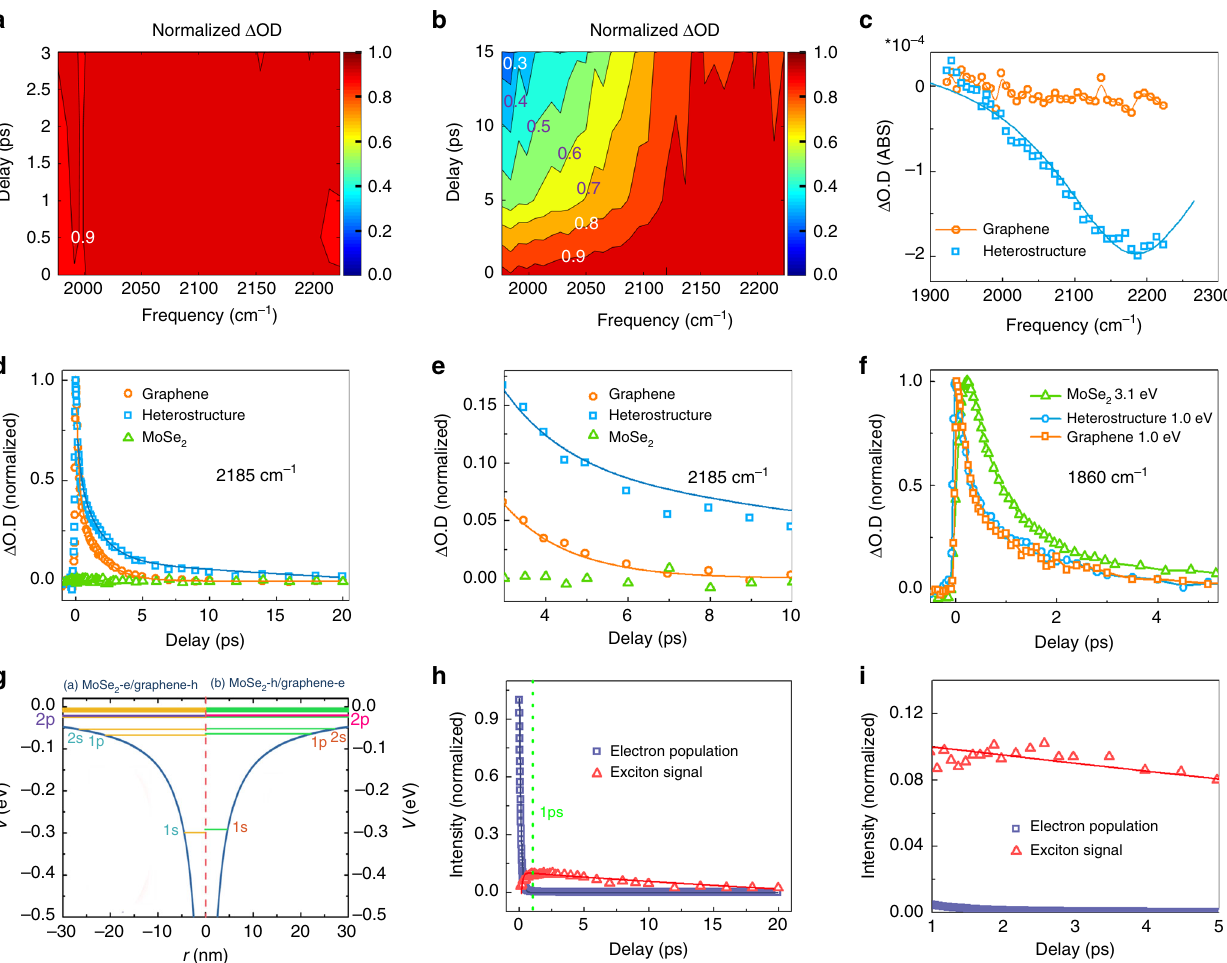
Fig. 3 Ultrafast measurements reveal the formation of interlayer excitons. Waiting time-dependent spectra of a graphene monolayer and b MoSe 2 / graphene heterostructure excited by 1.03 eV photons. The maximum intensity at each waiting time is set to be 1. Thus, the fi gures only re fl ect the changes of detection frequency dependence rather than decay dynamics. Each contour represents 10% intensity change. c Spectra of MoSe 2 /graphene heterostructure and graphene monolayer at 16 ps after excitation with 1.03 eV photons. The graphene signal (both dots and curve) is already zero, but the heterostructure signal is at peak. The peak is fi t with a Lorentzian centered at 2185 cm − 1 with a width 280 cm − 1 . Dots are data and the curve is calculation. d Waiting time-dependent transient IR signals detected at 2185 cm − 1 of monolayer graphene, MoSe 2 /graphene heterostructure, and MoSe 2 monolayer with 1.03 eV excitation. The dynamics of the heterostructure is apparently slower than graphene. Dots are experimental data, and lines are theoretical calculations. The negligibly small signal of MoSe 2 is normalized to the maximum intensity of the graphene signal. e Enlarged waiting time-dependent transient IR signals after 3 ps in Fig. 3d, which illustrates the nonzero tail of the heterostructure signal. f Waiting time-dependent transient IR signals detected at 1860 cm − 1 of the monolayer graphene and MoSe 2 /graphene heterostructure with 1.03 eV excitation, and MoSe 2 monolayer with 3.1 eV excitation. Different from the 2185 cm − 1 detection, within experimental uncertainty the dynamics of graphene and heterostructure are the same. Both are slower than the free-carrier dynamics in MoSe 2 monolayer with 3.1 eV excitation. g Calculated interlayer exciton energy levels of MoSe 2 /graphene heterostructure with graphene ’ s Fermi level at -0.17 eV with a 2D model. The calculations show a binding energy of about 0.3 eV for the interlayer excitons. h Calculated waiting time dependence of electronic dynamics (navy) for graphene with Fermi level at − 0.17 eV, and interlayer exciton signal (red). Lines are kinetic analyses. i Calculated huge population difference between excitons and free carrier after 1 ps in Fig. 3h, when the concentration of free carriers is close to